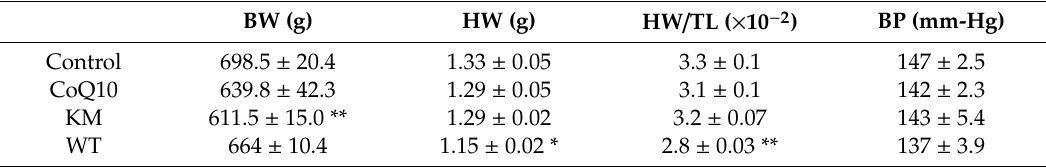
Table 2. Bodyweight (BW), heart weight (HW), heart weight (HW) / tibia length (TL) ratio and blood pressure (BP) in the control, coenzyme Q10 (CoQ10), Koralovij Marka (KM) and Wild Type (WT) groups.